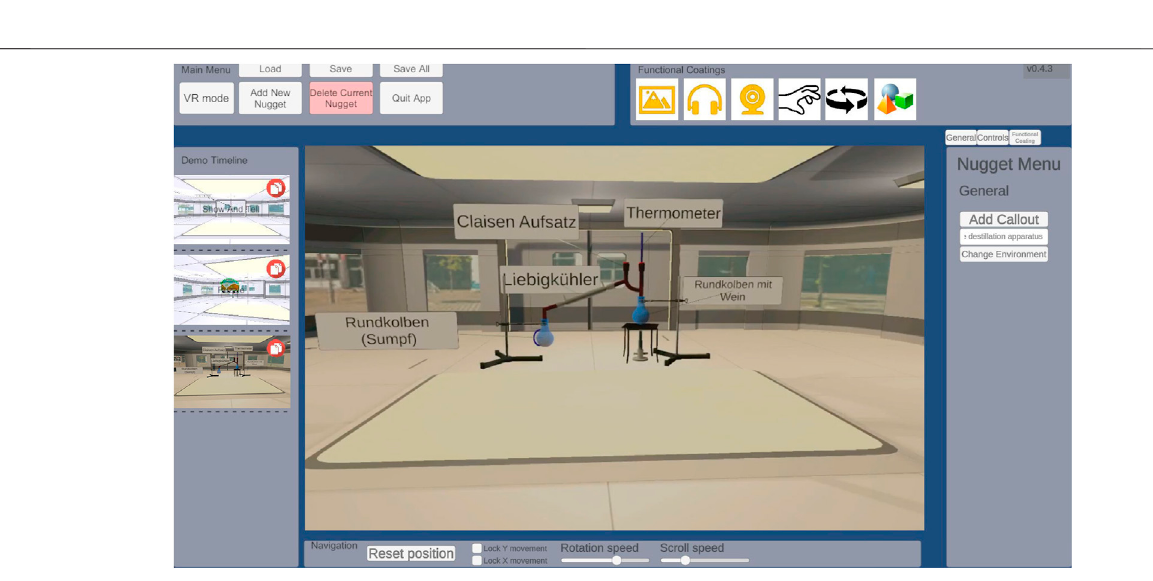
Frontiers in Virtual Reality |